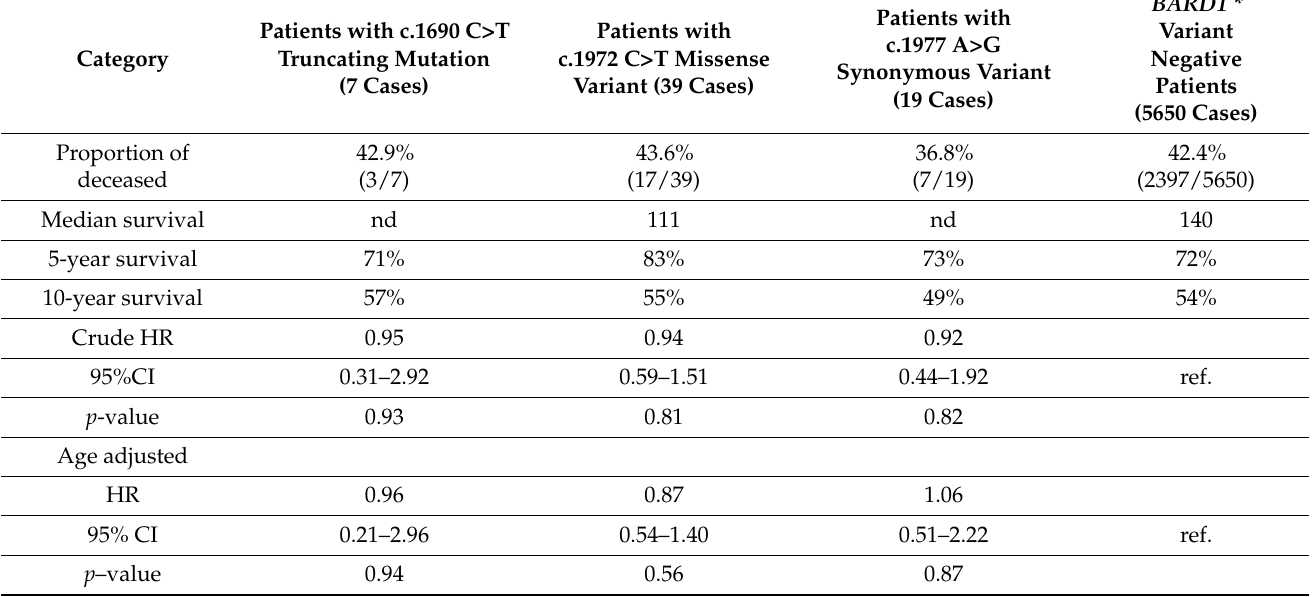
Table 3. Survival of prostate cancer patients with a BARD1 variant (7 patients with c.1690C>T, 39 patients with c.1972C>T and 19 men with c.1977A>G) and of BARD1 variant-negative prostate cancer patients (5650 non-carriers).